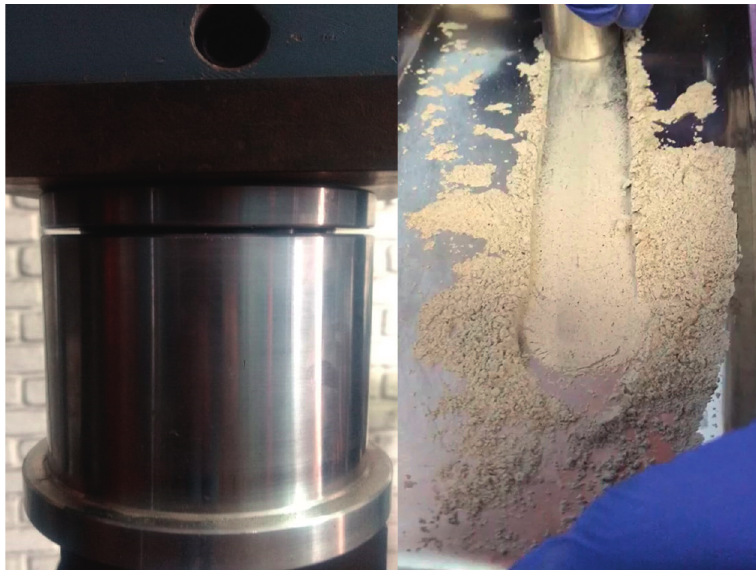
Figure 2: Pulverized mollusk shells.